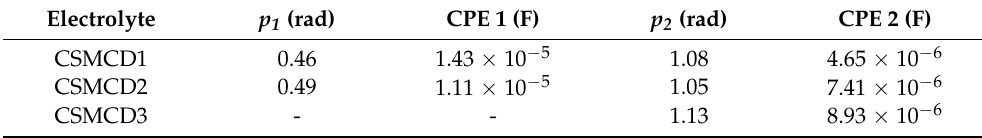
Table 2. The circuit elements values for the electrolytes. CPE: constant phase element. Electrolyte